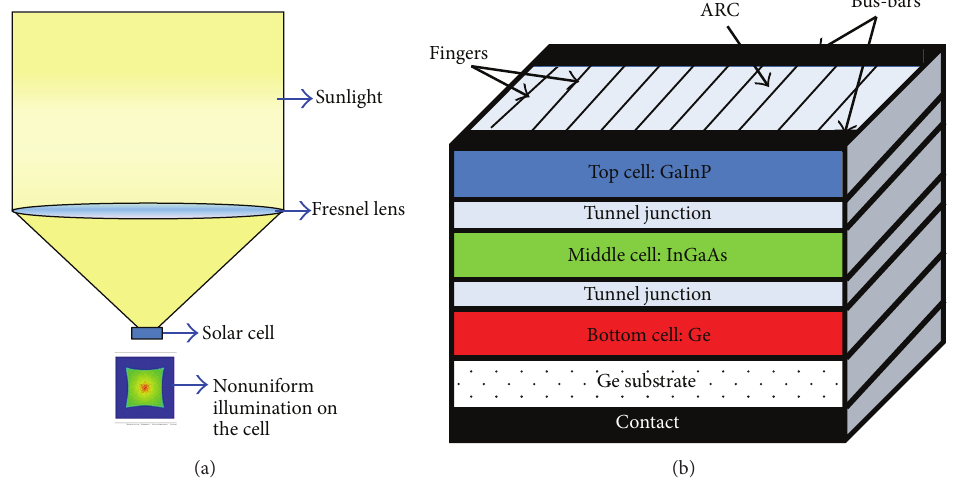
Figure 1: (a) A Fresnel-lens based CPV system showing nonuniform illumination on the solar cell. (b) Triple junction solar cell structure with a linear grid design; the bus-bars are outside the illumination area.